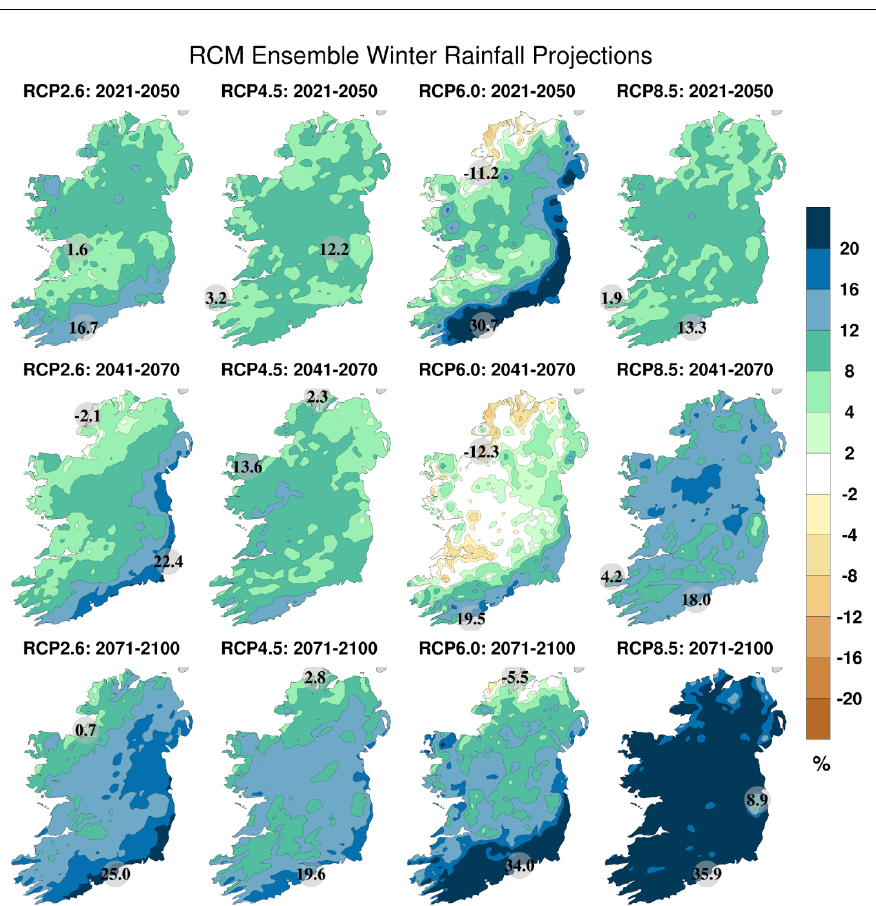
Figure 2. RCM ensemble projections of mean winter rainfall (in percent). The individual ensemble percentage projections are calculated as 100 × (future–past)/past. In each case, the future 30-year periods are compared with the past RCM period 1976–2005. The figure presents the mean of three RCP2.6 (low), five RCP4.5 (medium), one RCP6.0 (medium/high) and five RCP8.5 RCM (high) projections. The numbers included in each plot are the minimum and maximum projected changes, displayed at their locations. (Refer to Fig. 1 for the location of the study